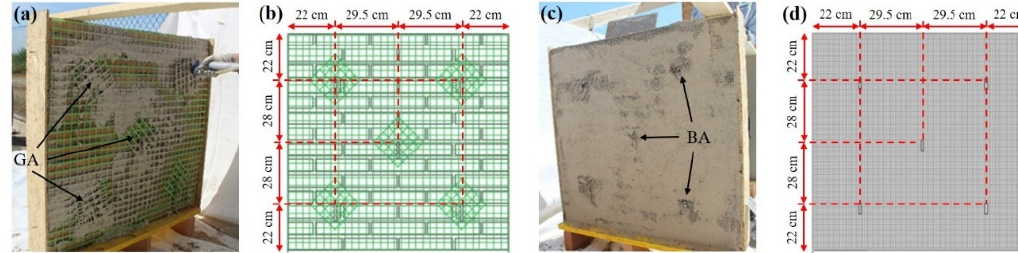
Figure 2. Strengthening systems: ( a ) GTRM; ( b ) GA configuration; ( c ) BTRM; ( d ) BA